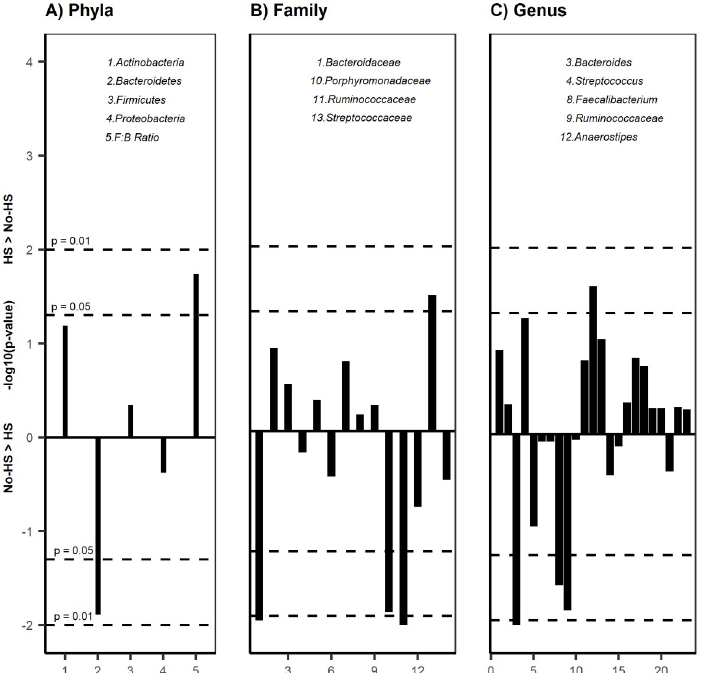
Fig 2. Percent relative abundance in HS and No-HS. Manhattan plot of bacterial %RA between groups at the A) Phyla B) Family and C) Genus level. Only taxa with > 1% RA are included. Lines above 0 are > %RA in HS and below 0 > %RA in No-HS, with dotted horizontal lines representing p < 0.05 and p < 0.01. HS had higher %RA of Firmicutes : Bacteroidetes ratio and lower Bacteroidetes . At the family level, HS had higher %RA of Streptococcaceae , and lower Bacteroidaceae , Porphyromonadaceae , and Ruminococcaceae . At the genus level, HS had higher %RA of Streptococcus and Anaerostipes , and lower %RA of Bacteroides , Faecalibacterium and Ruminococcaceae .